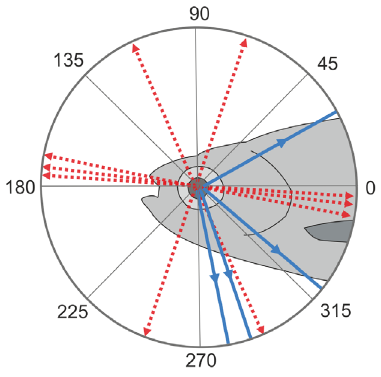
Figure 6. Summary plot of direction and orientation prefer- ences. The blue, solid lines with arrowheads indicate the preferred direction of motion of the significantly direction-selective neurons relative to the fish’s body axis. The red, broken lines with arrowheads at both ends indicate the preferred axes of motion of the significantly orientation-selective neurons. Note that the corresponding stripe orientation of the grating is in all cases perpendicular to these axes (see inset at 45 u